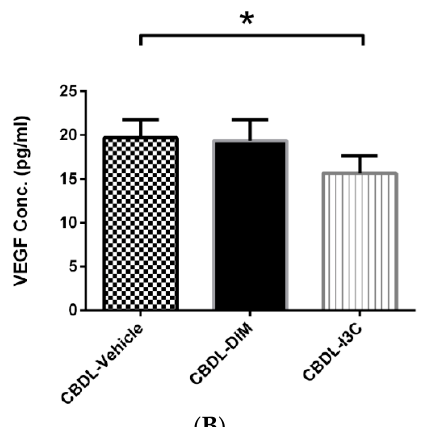
Figure 1. ( A ) The degree of portosystemic shunting of CBDL rats treated with vehicle, DIM (3,3 ′ -diindolymethane), or I3C (Indole-3-carbinol) analyzed with ANOVA. I3C significantly decreased the degree of shunting (* p < 0.05, I3C vs. corresponding vehicle group). ( B ) The plasma VEGF (vascular endothelial growth factor) concentrations analyzed with ANOVA. Compared with vehicle, I3C significantly decreased the plasma VEGF concentration (* p < 0.05, I3C vs. vehicle).